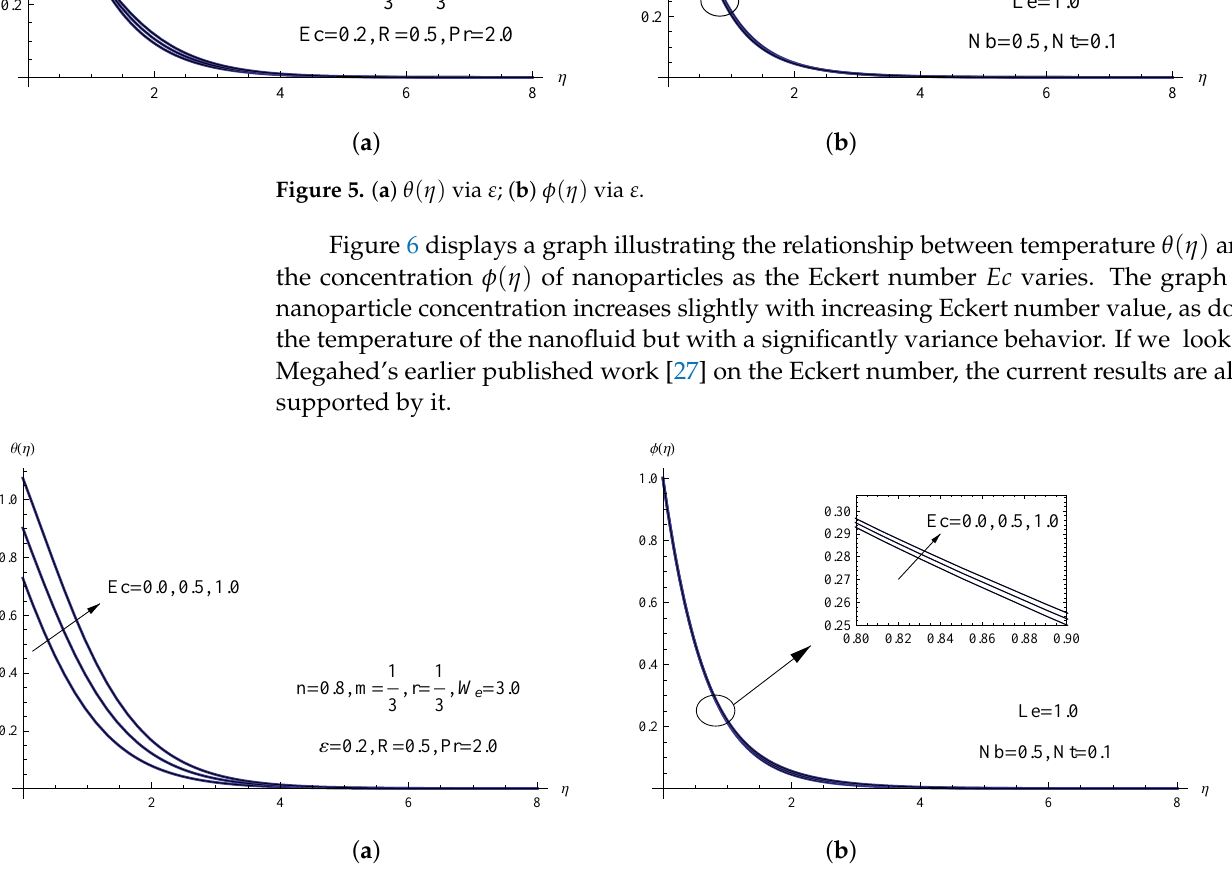
Figure 6. ( a ) θ ( η ) via Ec ; ( b ) φ ( η ) via Ec . Temperature θ ( η ) and concentration φ ( η ) distribution are depicted in Figure 7 to- gether with the thermophoresis parameter’s Nt variation. In the temperature profile, the thermophoresis parameter marginally improved the temperature distribution compared to the nanoparticle concentration distribution. This behavior will assist to thicken the thermal boundary layer and raise the sheet temperature θ ( 0 ) . The thermophoresis phenomenon, in terms of its physical meaning, entails the evacuation of warmed particles from a heated surface and their transport to a cool environment. As a result, the fluid’s temperature goes